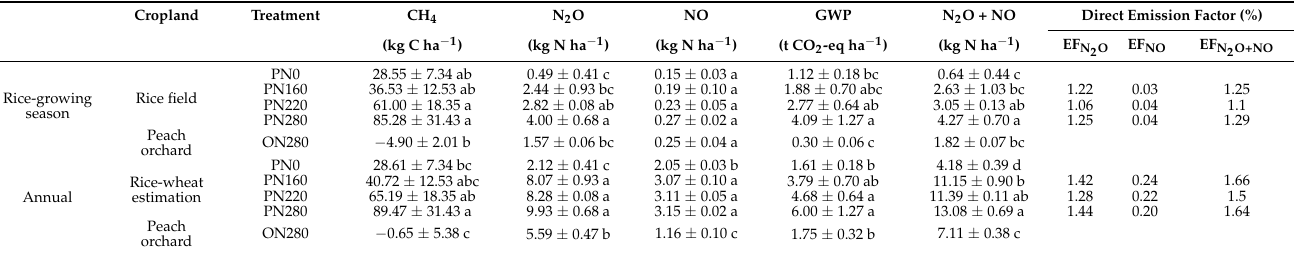
Table 2. Cumulative fluxes of CH 4 , N 2 O, NO, CH 4 plus N 2 O, and N 2 O plus NO for the rice-growing season and annual rice field and peach orchard, as well as direct emission factors (EF) of N 2 O, NO, and N 2 O plus NO for rice cropping systems. Data for the wheat growing season were obtained from the average emissions from conventional fertilizer treatments in previous rice–wheat rotation studies in the same region. Values are means ± SE ( n = 3). Means that do not share a letter are statistically significantly different from each other ( p <